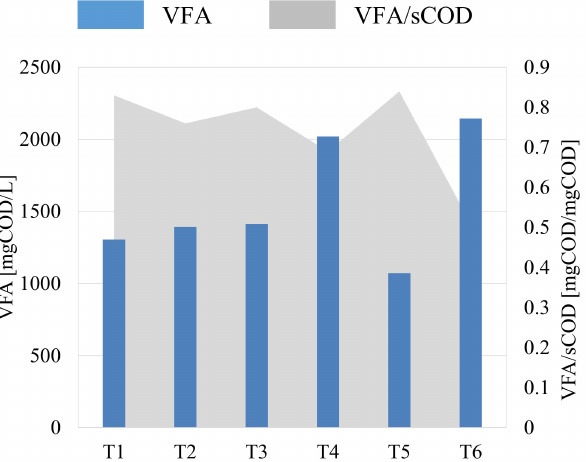
Figure 10. VFA concentration and VFA/sCOD ratio of the fermented liquid during the batch test.